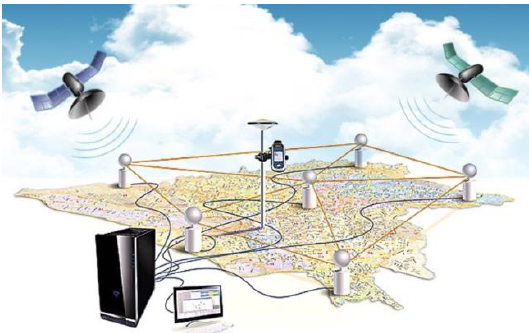
Figure 12: Instantaneous positioning system (Real-time kinematic (RTK) positioning